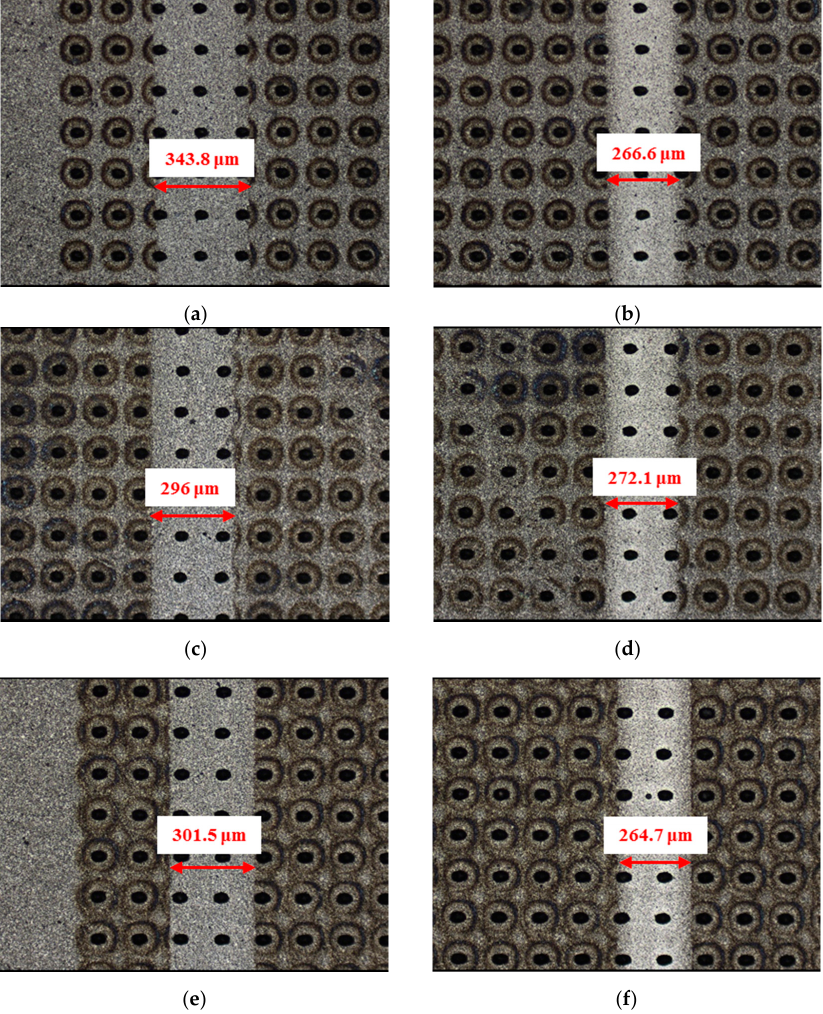
Figure 12. Wear performance of circular-dimple-textured SiC under oil-lubricated conditions with a load of 75 N (×10): ( a ) 3 μ m circular-dimple-textured SiC-steel ball, ( b ) 3 μ m circular-dimple-textured SiC–Si 3 N 4 ball, ( c ) 5 μ m circular-dimple-textured SiC–steel ball, ( d ) 5 μ m circular-dimple-textured SiC–Si 3 N 4 ball, ( e ) 10 μ m circular-dimple-textured SiC–steel ball, and ( f ) 10 μ m circular-dimple-textured SiC–Si 3 N 4 ball.